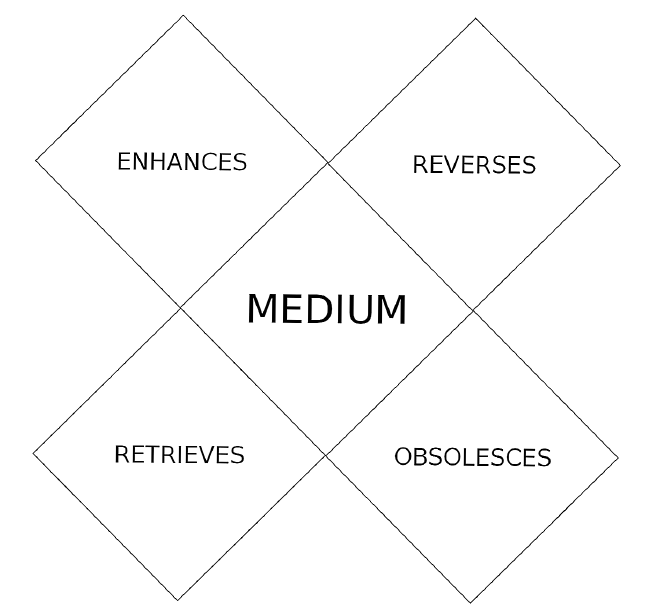
on the original model developed by M. & E.